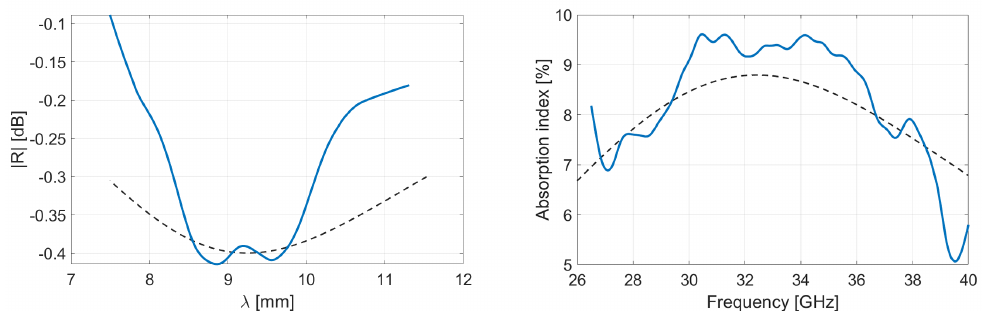
Figure 12. Reflectivity and absorption performances of the virgin Salisbury structure. The resistive layer is VPLA–4%OMMT 200 µm-thick film and the lossy material is VPLA 1.2 mm-thick. The dotted line is the simulation of the performance based on material properties.